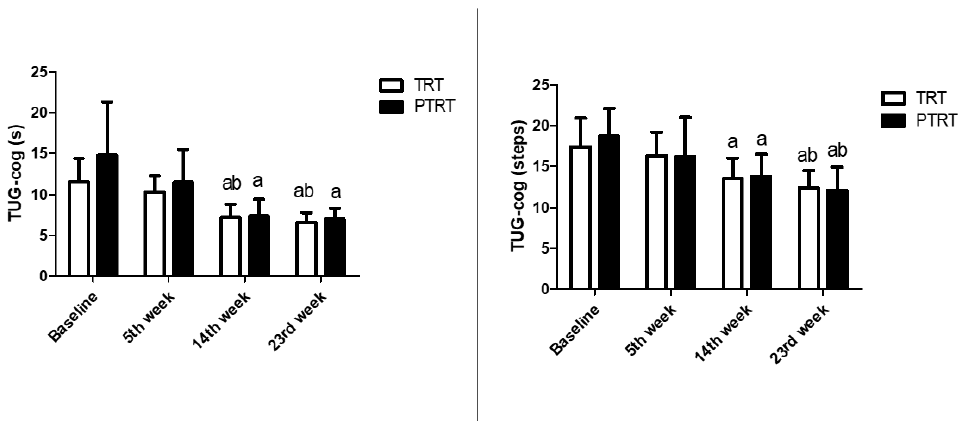
Figure 2. Time-course effects of TRT and PTRT on cognitive function. TRT = Traditional resistance training; PTRT = Power training resistance training; TUG-cog = Timed “Up-and-Go”- cognitive; a p < 0.05 vs. Baseline; b p < 0.05 vs. 5th week.